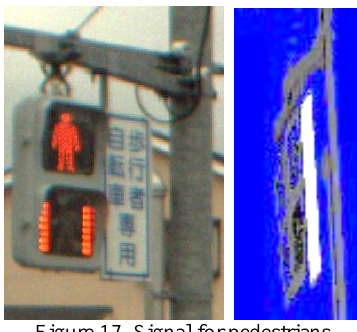
Figure 17. Signal for pedestrians